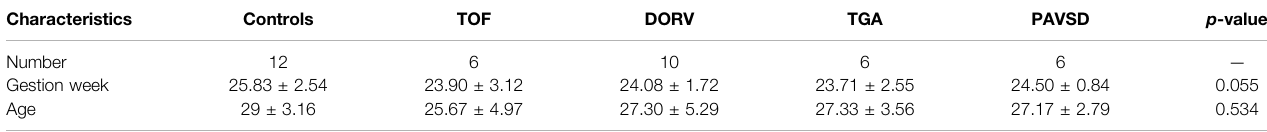
TABLE 1 | Demographic and clinical data of cases and